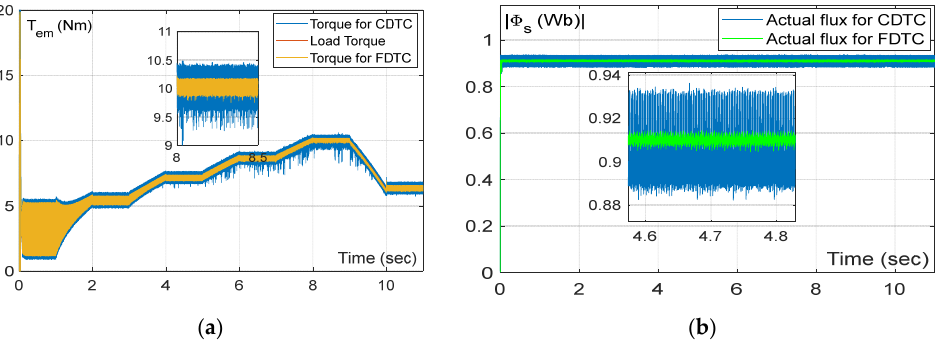
Figure 13. ( a ) Electromagnetic torque response for CDTC and FDTC, and ( b ) stator flux module for CDTC and FDTC. Table 6. Proposed FDTC performance: A comparative